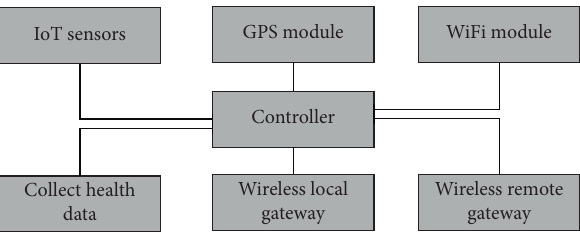
Figure 2: Components involved and architecture.